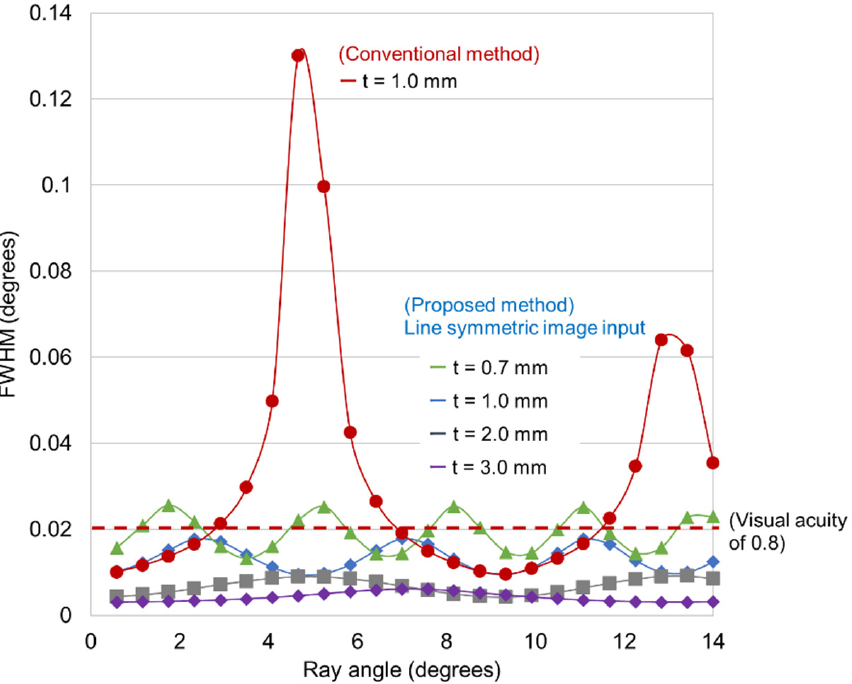
Figure 7. Waveguide thickness and FOV-dependence of display resolution with line-symmetric image input.